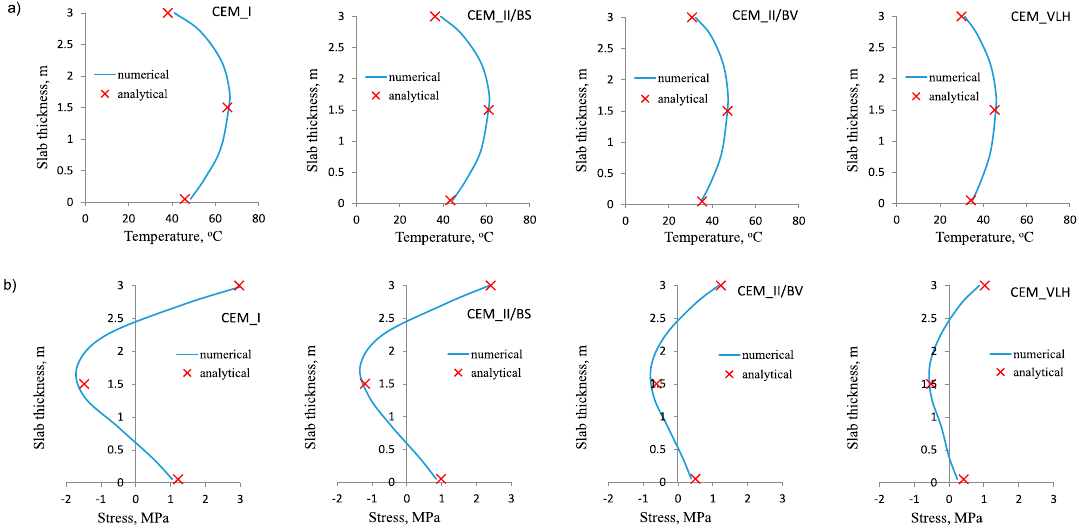
Figure 8. Numerical and analytical results for slabs made of concrete with different cements: ( a ) Temperature distribution at the slab thickness, ( b ) total stress distribution at the slab thickness.